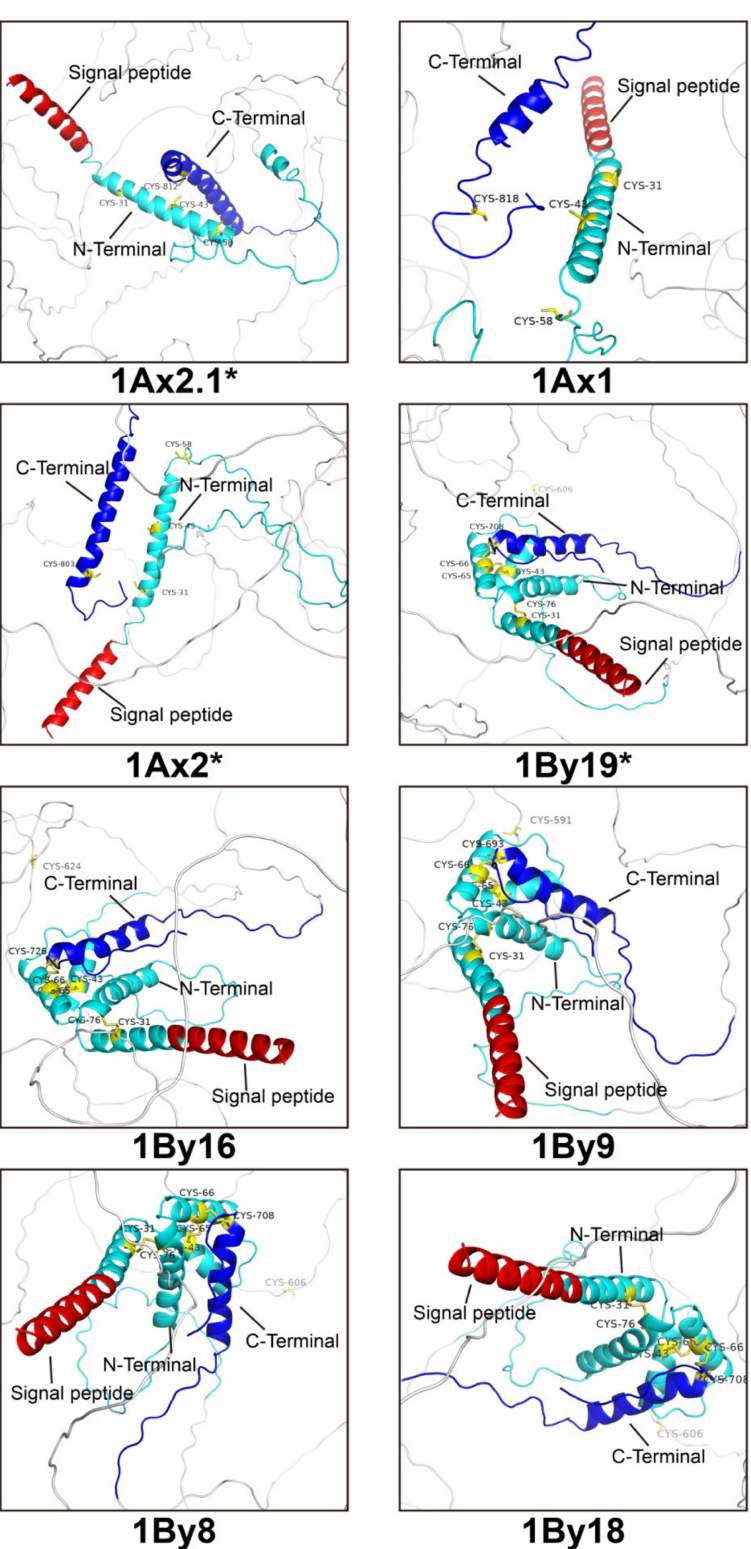
Figure 5. Localized view of the 3D structures of eight wheat HMW-GS by